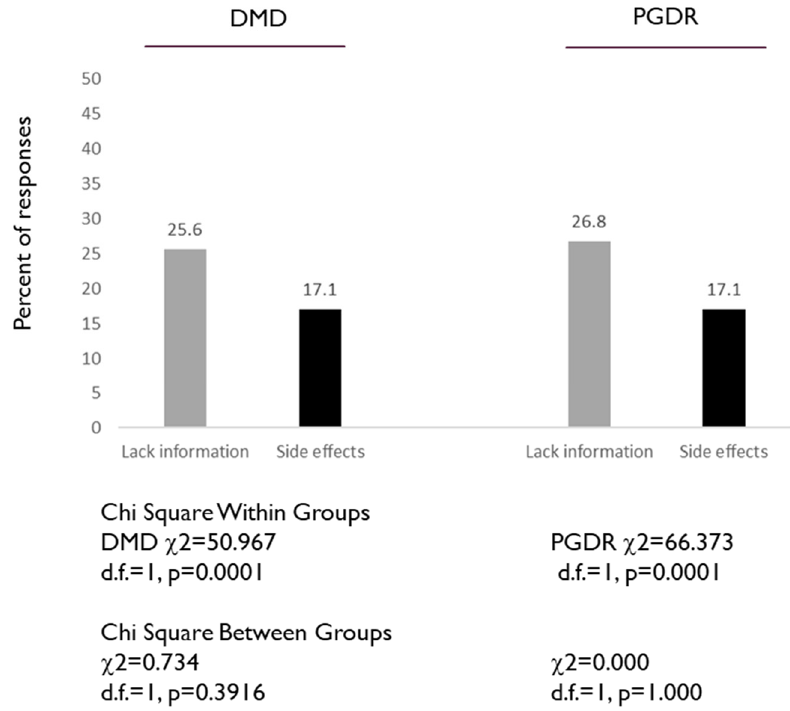
Figure 4. Assessment of DMD and PGDR responses to specific HPV-related questions: I do not have enough information about the HPV vaccine, and I am concerned about possible HPV vaccine side e ff ects. Both groups (DMD, PGDR) had similar percentages of agreeing they did not have enough information regarding the HPV vaccine (25.6% and 26.8% respectively), p = 0.396. In addition, the same percentage of both the DMD and PGDR responders indicated they had concerns about possible HPV vaccine side e ff ects (17.1%).